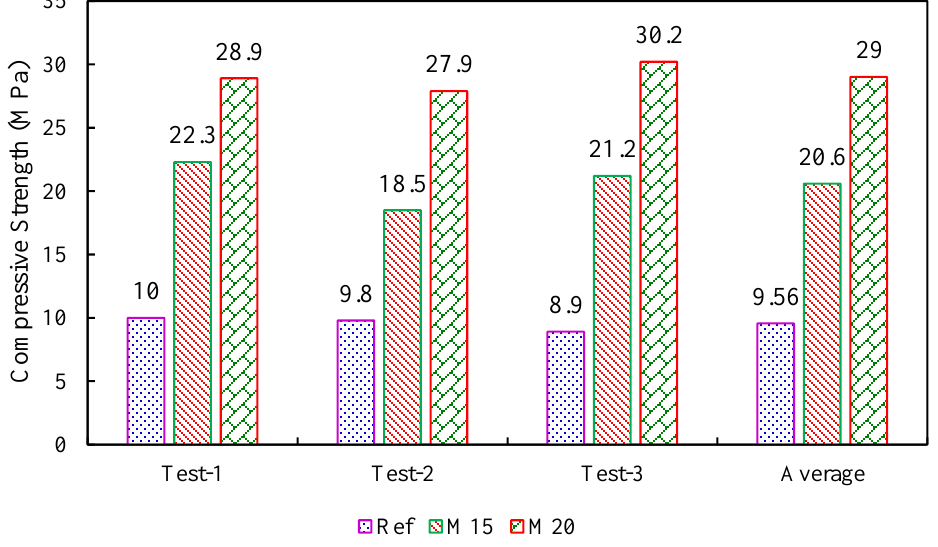
Figure 8. Compressive strength results of EPS with M15 and M20 concrete mixes. Figure 9 depicts the load-deformation graph of ICF wall panels and masonry